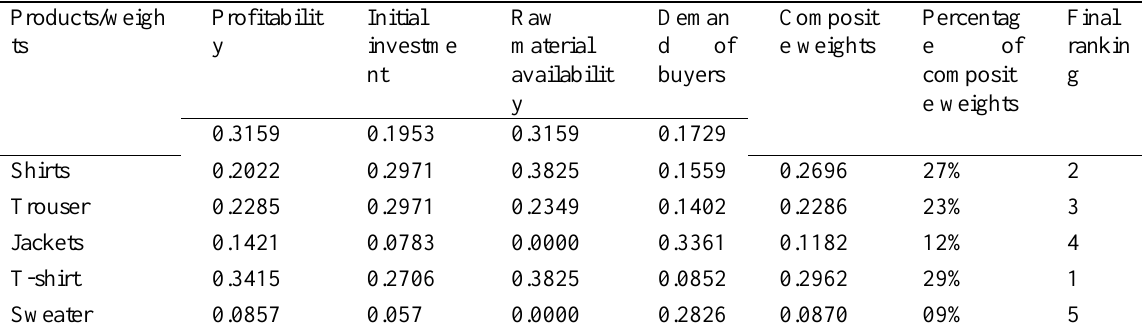
Table 11 . Final evaluation of the Fuzzy-AHP